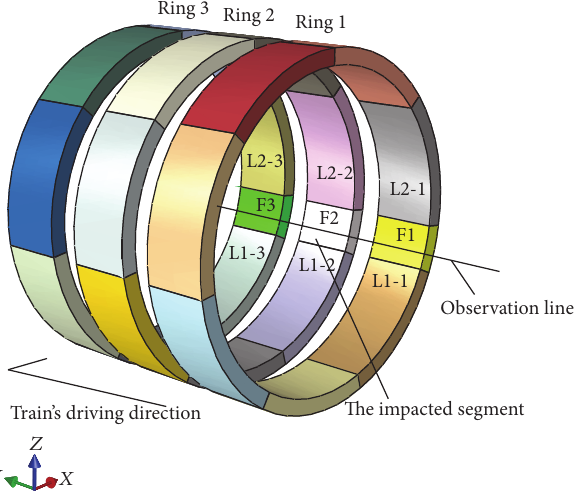
Figure 3: Schematic diagram of the segmental lining.